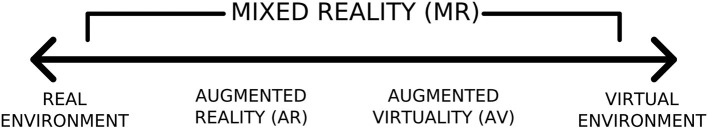
Milgram's continuum (Milgram and Kishino, 1994).